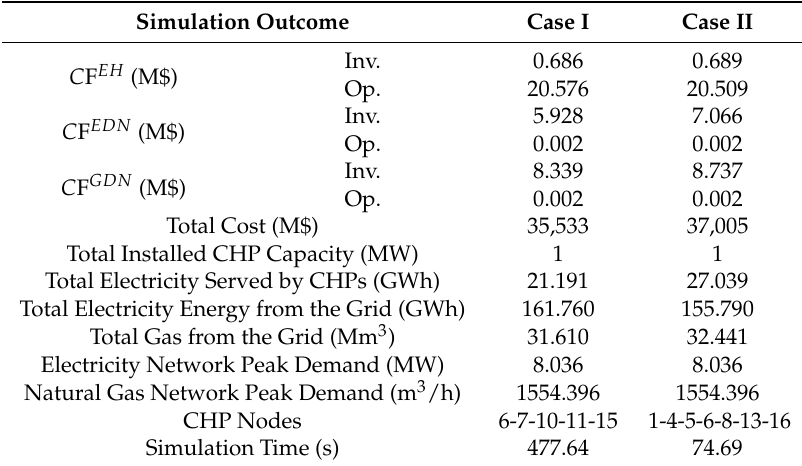
Table 1. Comparison of Outcomes for two